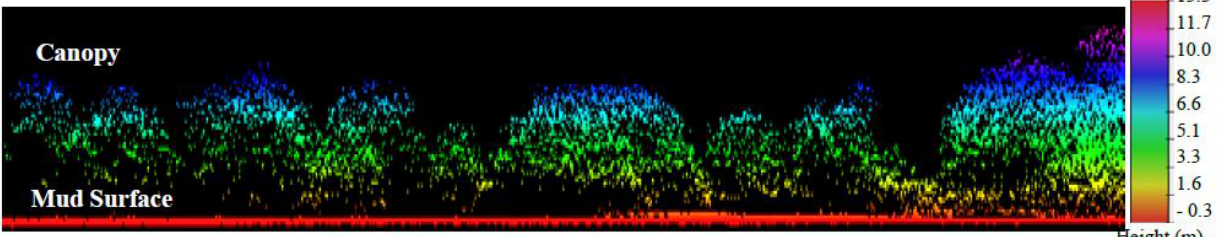
Figure 2. Vertical mangrove profile of LiDAR data in the study area.